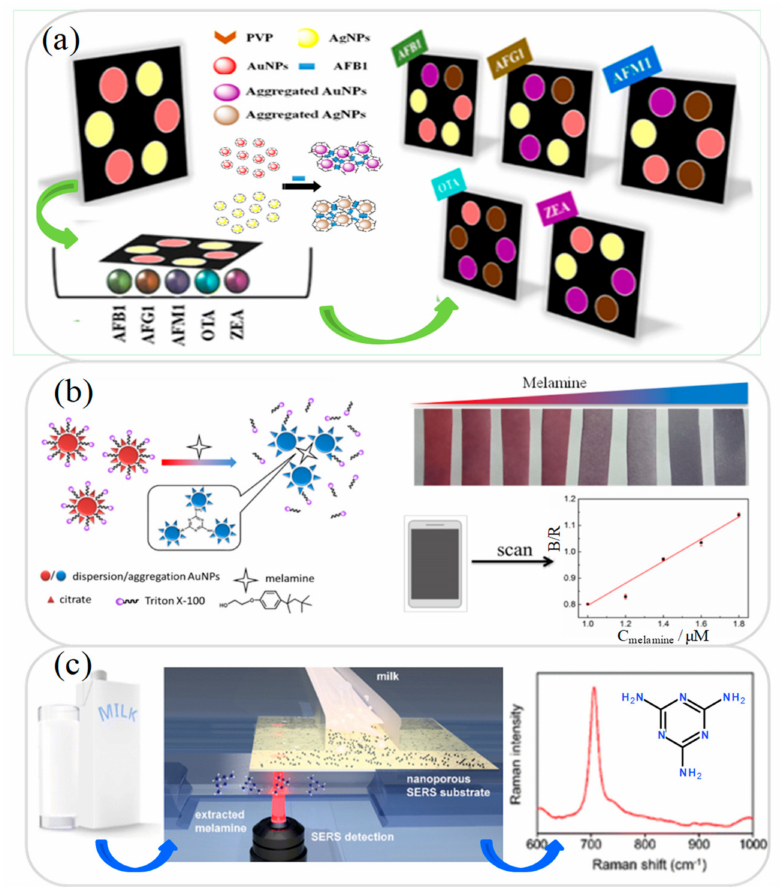
Figure 2. ( a ) Microfluidic colorimetric array device based on AuNPs and AgNPs for detection of aflatoxins, ochratoxins, and zearalenone. Reprinted with permission from ref. [54]. Copyright 2020 Springer. ( b ) Schematic illustration showing working principle of microfluidic colorimetric sensor based on modified AuNPs for detection of melamine. Reprinted with permission from ref. [63]. Copyright 2018 Elsevier. ( c ) Schematic illustration showing microfluidic device combined with SERS detector for determination of melamine. Reprinted with permission from ref. [66]. Copyright 2020